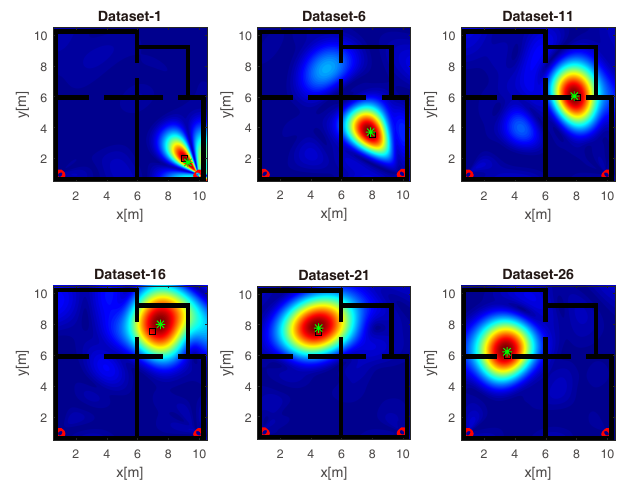
Figure 18. Tomographic images of a narrow band source achieved with multiplicative array image fusion (E). Arrays (red circles); true source position (black square); estimated source position (green asterisk). Color scale is [0, 1].